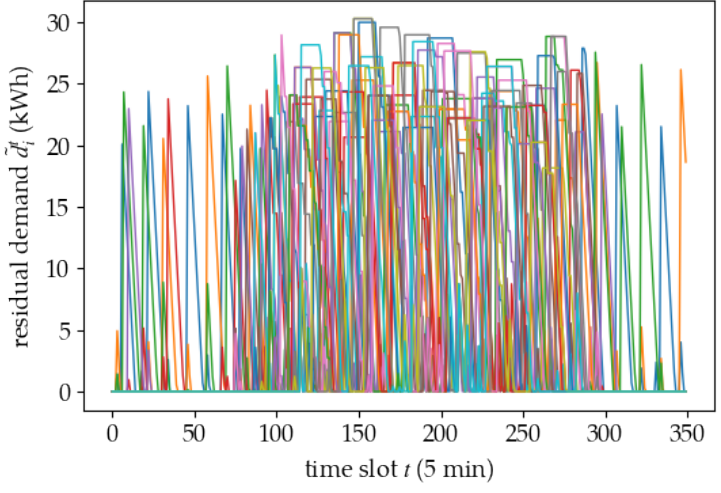
Figure 21. Residual demand per charger for the first 350 time slots (three-day episode